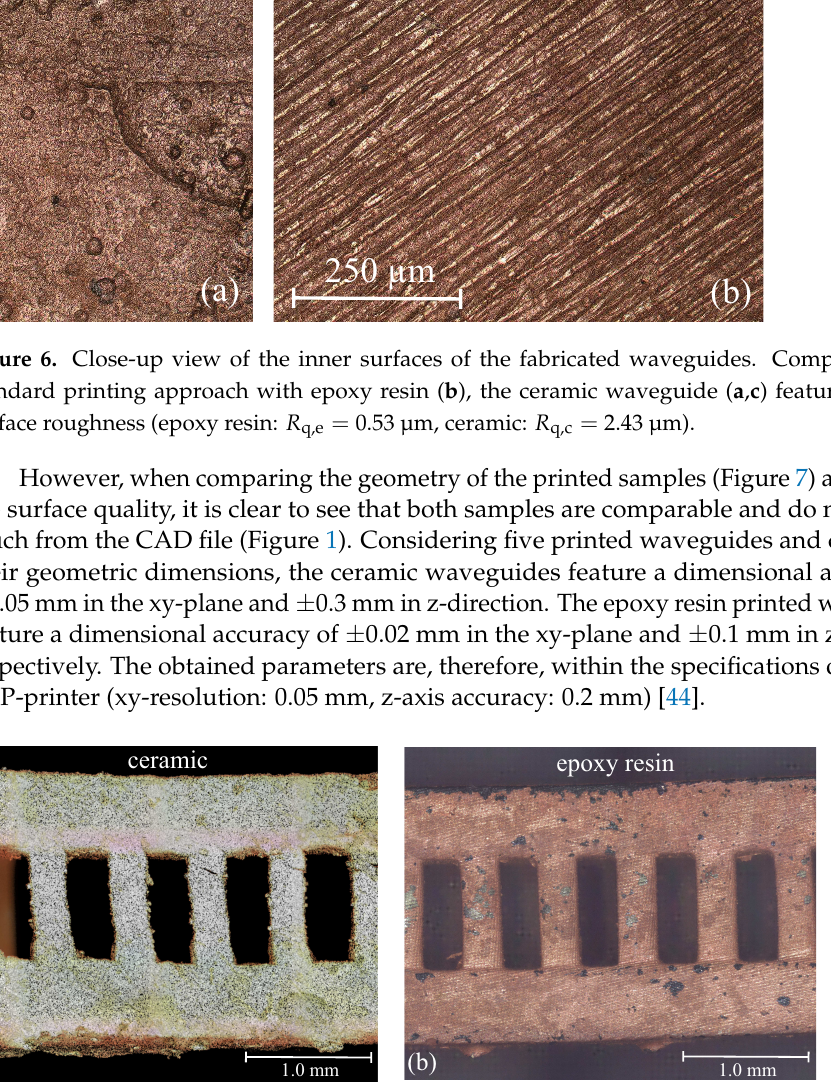
Figure 7. Close-up view of the narrow walls of the fabricated ceramic WR12 waveguide ( a ) in compar- ison to the standard printing approach with epoxy resin ( b ). The slot geometries are almost